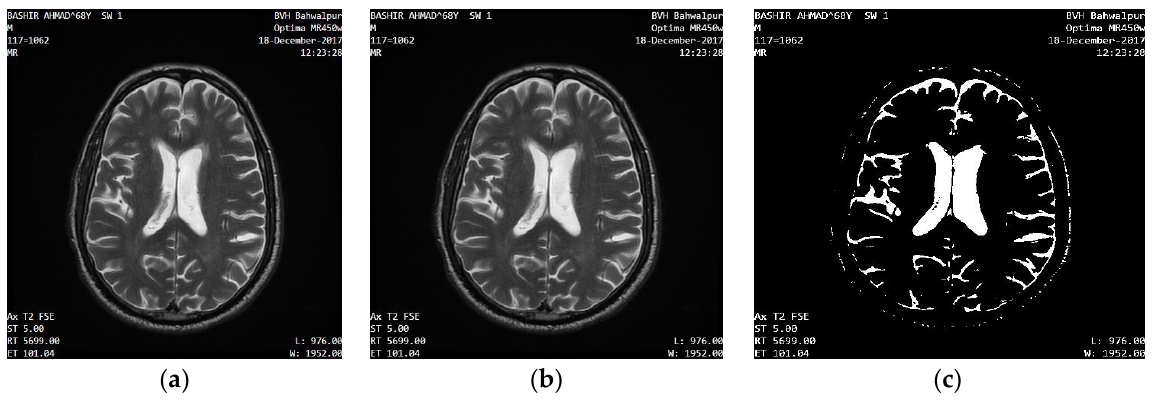
Figure 1. BVH dataset. ( a ) Original image; ( b ) converted grayscale; ( c ) binarized image.